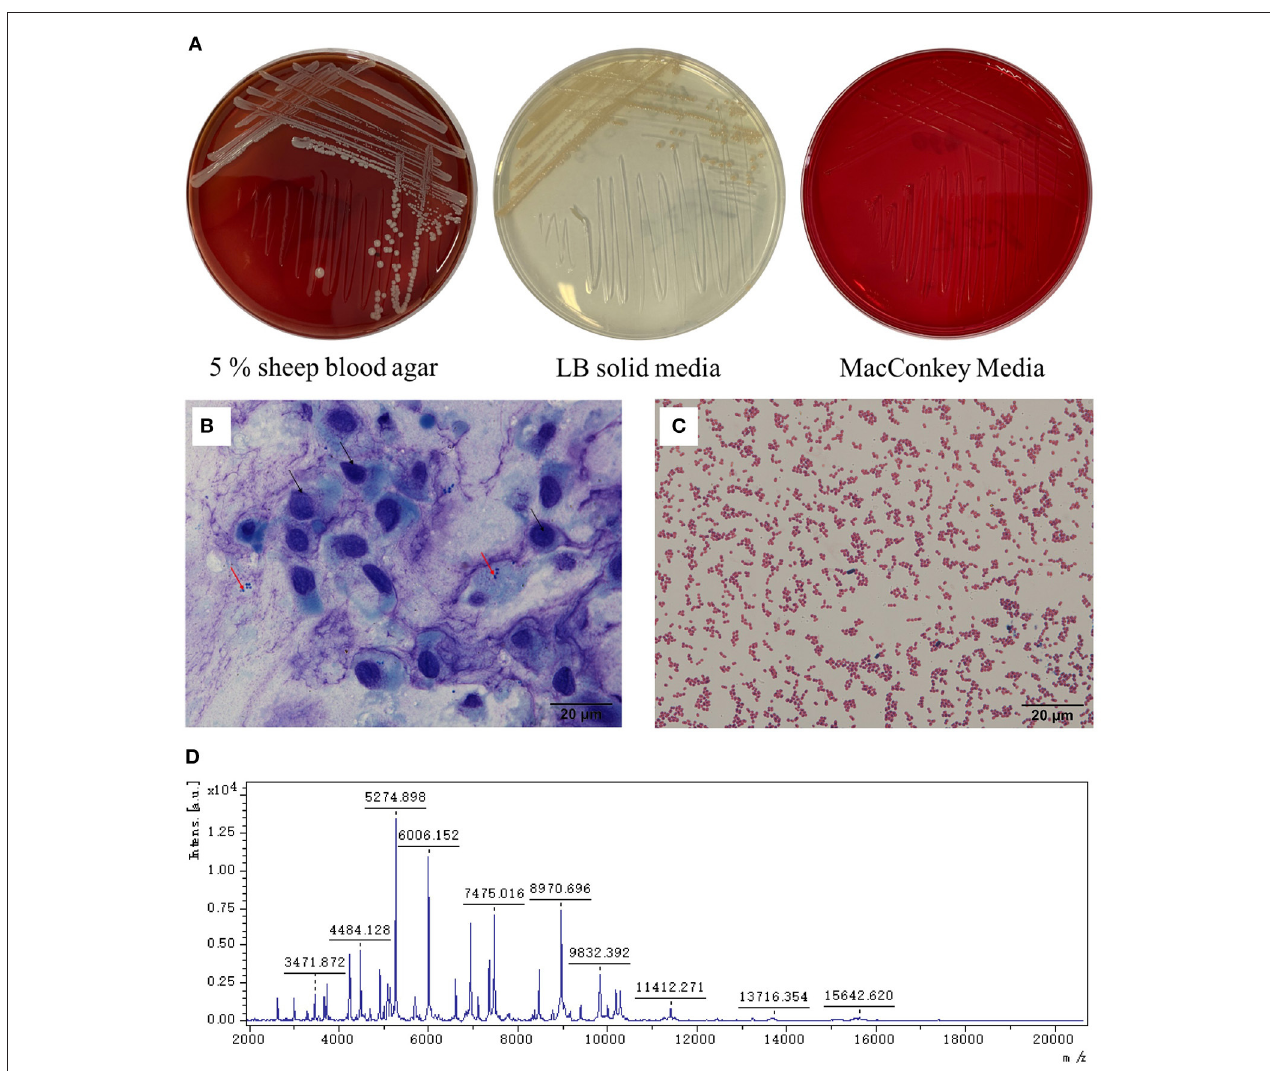
FIGURE 2 | Staining and microscopic examination from the corneal ulceration foci sample collected by sterile cytobrush and pathogen isolation. (A) The colonies were white and β -hemolysis in 5% sheep blood agar, light yellow in LB solid medium, and no colonies grown on the MacConkey media. (B) The sample was stained by Wright-Giemsa stain. The black arrow refers to the shed corneal cells, and the red arrow refers to the bacteria (10 × 100). (C) The bacteria from the culture were dyed by the Gram stain solution and by microscope (10 × 100). (D) The mass spectrum peak of the isolated